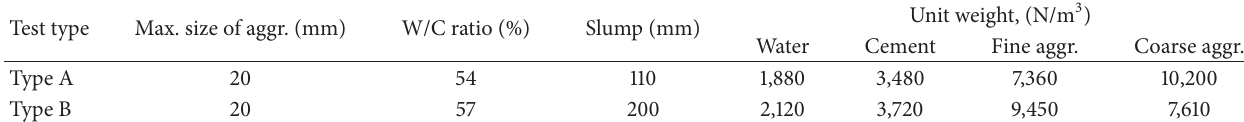
Table 1: Mixture proportions for the two test types of concrete.